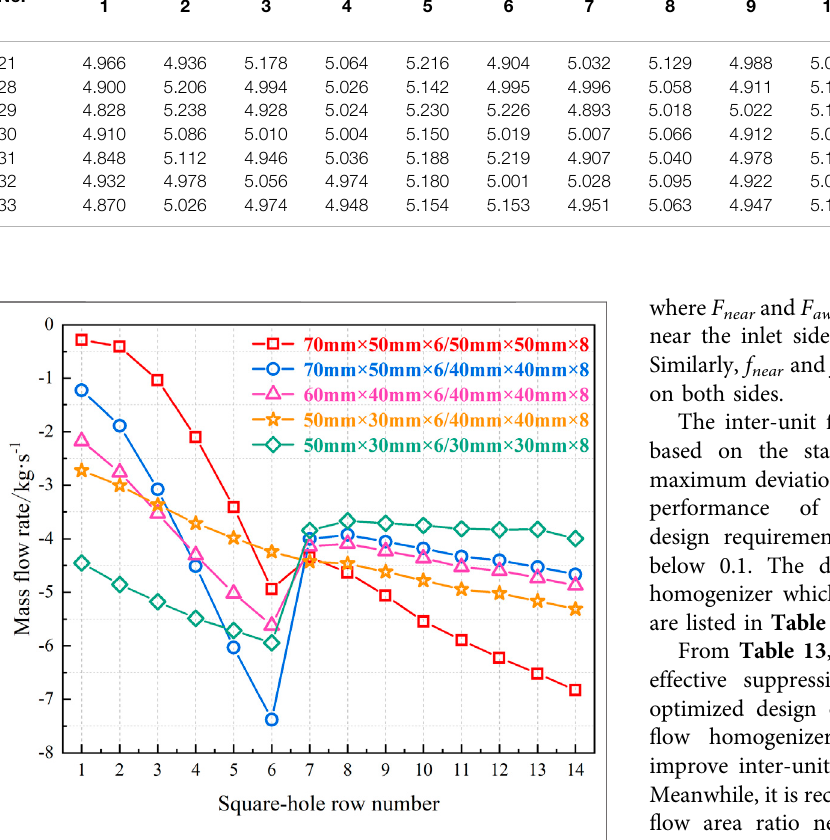
TABLE 12 | Numerical results of inter-unit fl ow rate distribution for fl ow homogenizers with different square hole sizes. Case No.